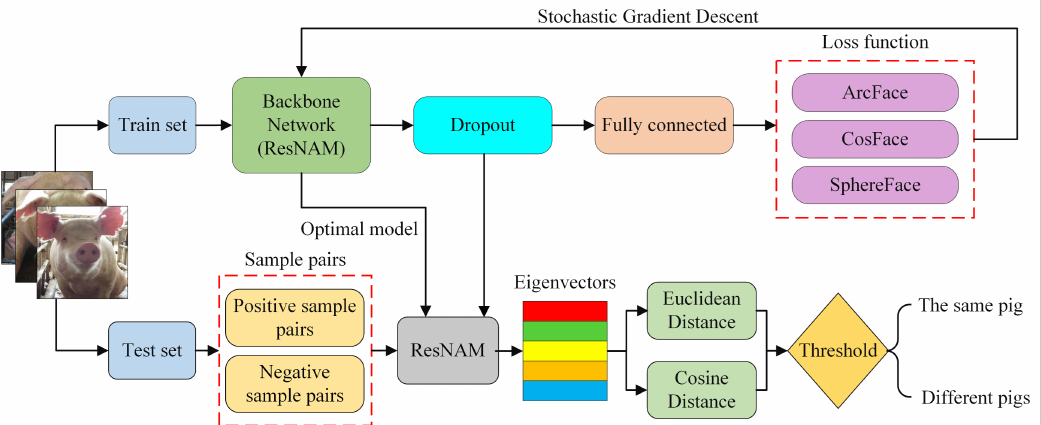
Figure 5. Open-set identification method for pig